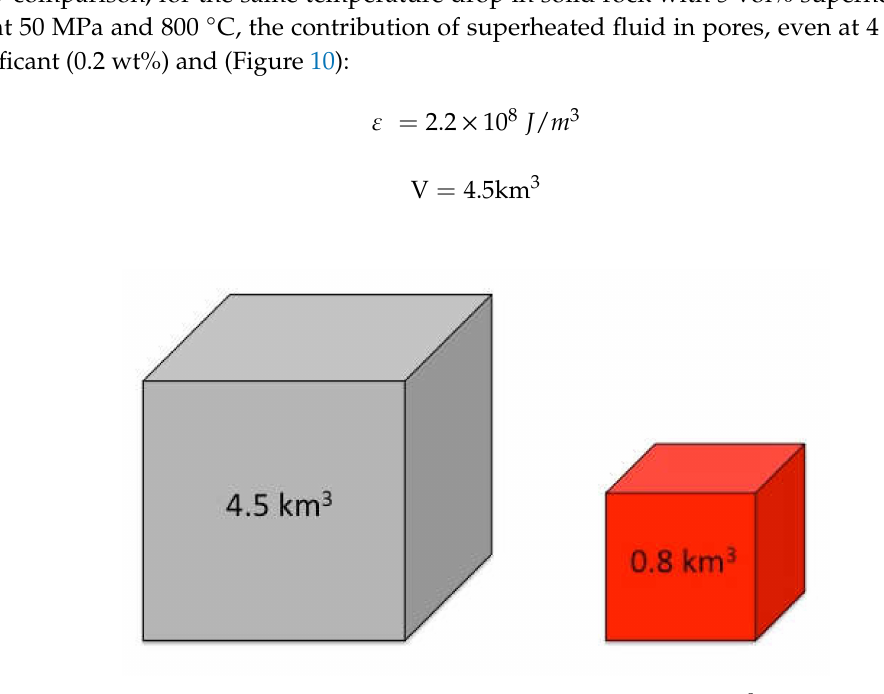
Figure 10. The volume of rock (gray) or magma (red) required to release 10 9 GJ of thermal energy during cooling of ∆ T = 100 ◦ C. For the magma, the temperature drop is chosen to be liquidus to solidus, thereby releasing all the latent heat of crystallization. For the rock, where the energy content is entirely sensible heat, only the size of the temperature interval is